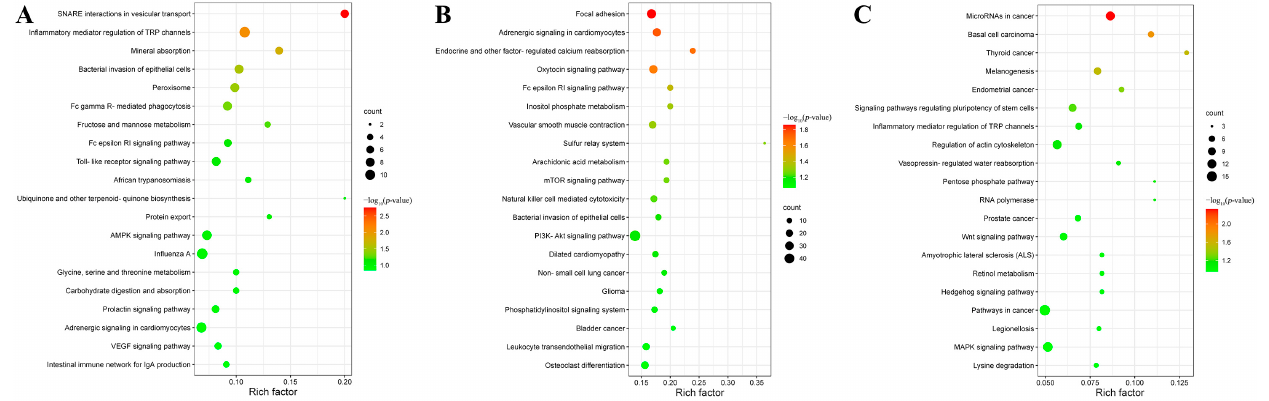
Figure 2. Scatter plots of the top 20 KEGG pathways of the potential targeted genes of differentially expressed miRNAs (DEmiRNAs) at ( A ) 24 h post-infection (hpi), ( B ) 96 hpi, and ( C ) 36 days post- infection (dpi) in the spleen of puppies. The rich factor is represented by the X -axis label, and the KEGG pathway name is displayed on the Y -axis label. The percentage of DEmiRNAs-targeted genes in a specific pathway is reflected in the rich factor. The dots’ colors represent the enrichment score [ − log 10 ( p -value)], with green representing low enrichment and red representing high enrichment. The number of targeted genes of DEmiRNAs in the appropriate pathway is represented by the size of the dots (bigger dots indicate larger number of DEmiRNAs targeted genes).